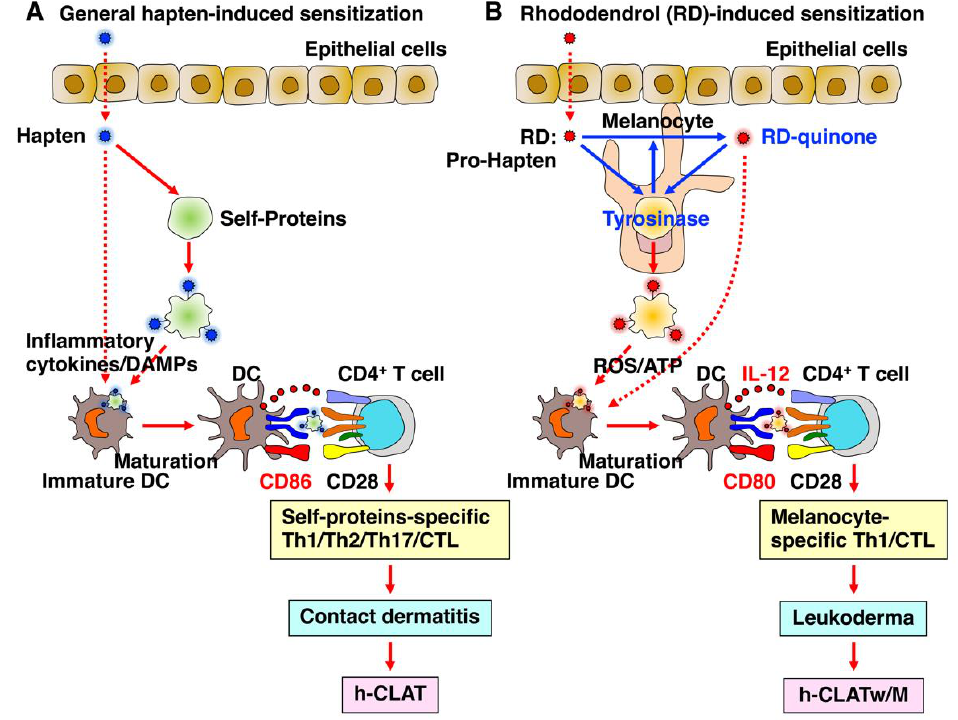
Figure 3. Comparison between general hapten-induced sensitization and RD-induced sensitization. Generally, a skin sensitizer is considered to be hapten-specific for proteins present abundantly and broadly in serum and cells, inducing an allergic reaction across an expansive layer of skin when exposed again to the sensitizer ( A ). By contrast, RD is unique in being a pro-hapten specific for melanocytes that metabolizes into its hapten sensitizer, RD-quinone, by oxidation in melanocytes, resulting in ROS production and ATP release, and the resultant upregulation of CD86 and IL-12, which lead to the induction of leukoderma ( B ). The former can be detected by using h-CLAT and the latter can be detected by using h-CLATw/M.